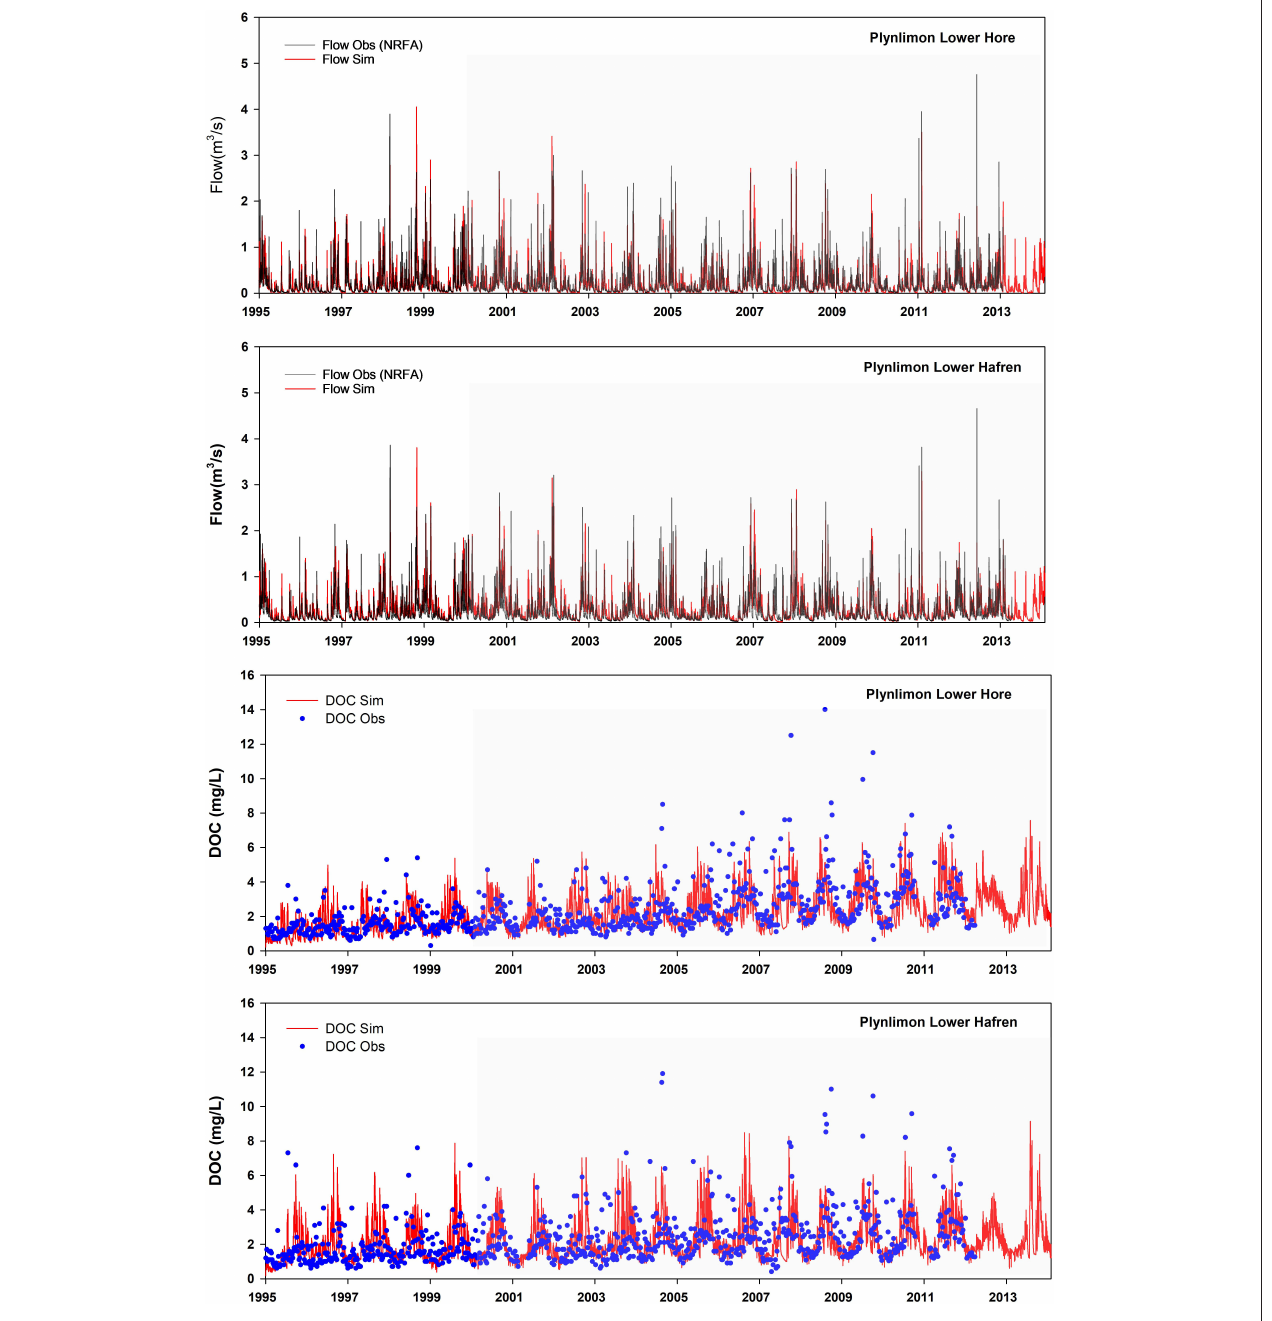
FIGURE 5 | INCA-C calibration and validation results (Flow and DOC) at two locations in Plynlimon catchment. The gray-shaded area is the time period used for calibration. The unshaded area is used for